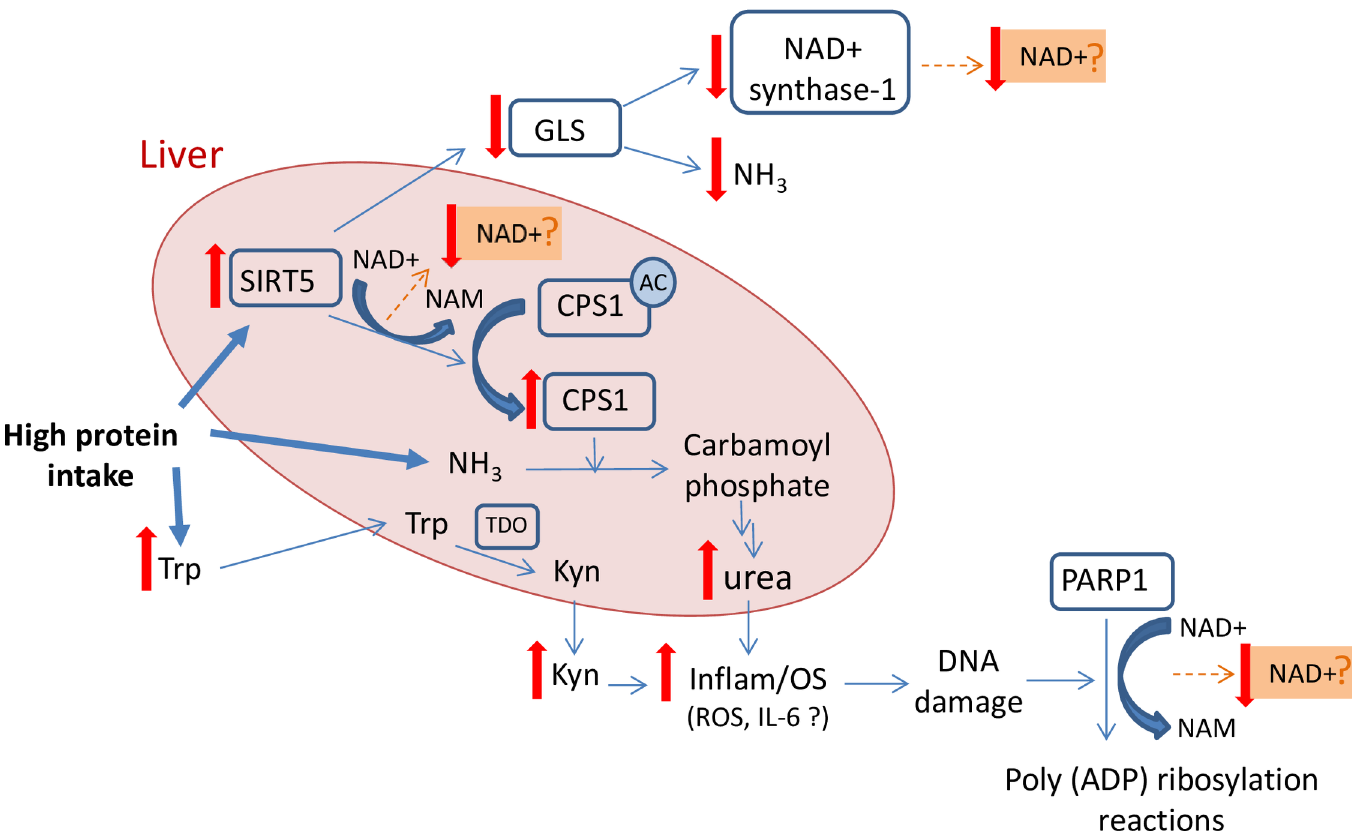
Fig 4. Theoretical mechanism for the contribution of high protein intake to NAD + and its metabolites levels [30– 34, 44, 48]. SIRT5: Sirtuin 5; NAD + : Nicotinamide adenine dinucleotide; NAM: Nicotinamidec; NH 3 : Ammonia; GLS: Glutaminase; AC: Acetyl; CPS1: Carbamoyl phosphate synthetase 1; Trp: Tryptophan; Kyn: Kynurenine; TDO: Tryptophan 2,3-Dioxygenase; Inflam: inflammation; OS: Oxidative stress; ROS: Reactive oxygen specious; Interleukin-6; cADPR: Cyclic ADP ribose; PARPs: Poly ADP-ribose